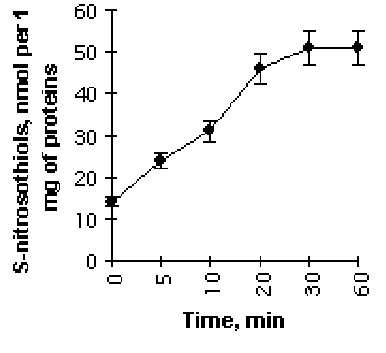
Fig. 2 . Dependence of S-nitrosothiols concentration in the rat liver homogenate on the time of homogenate incubation with sodium